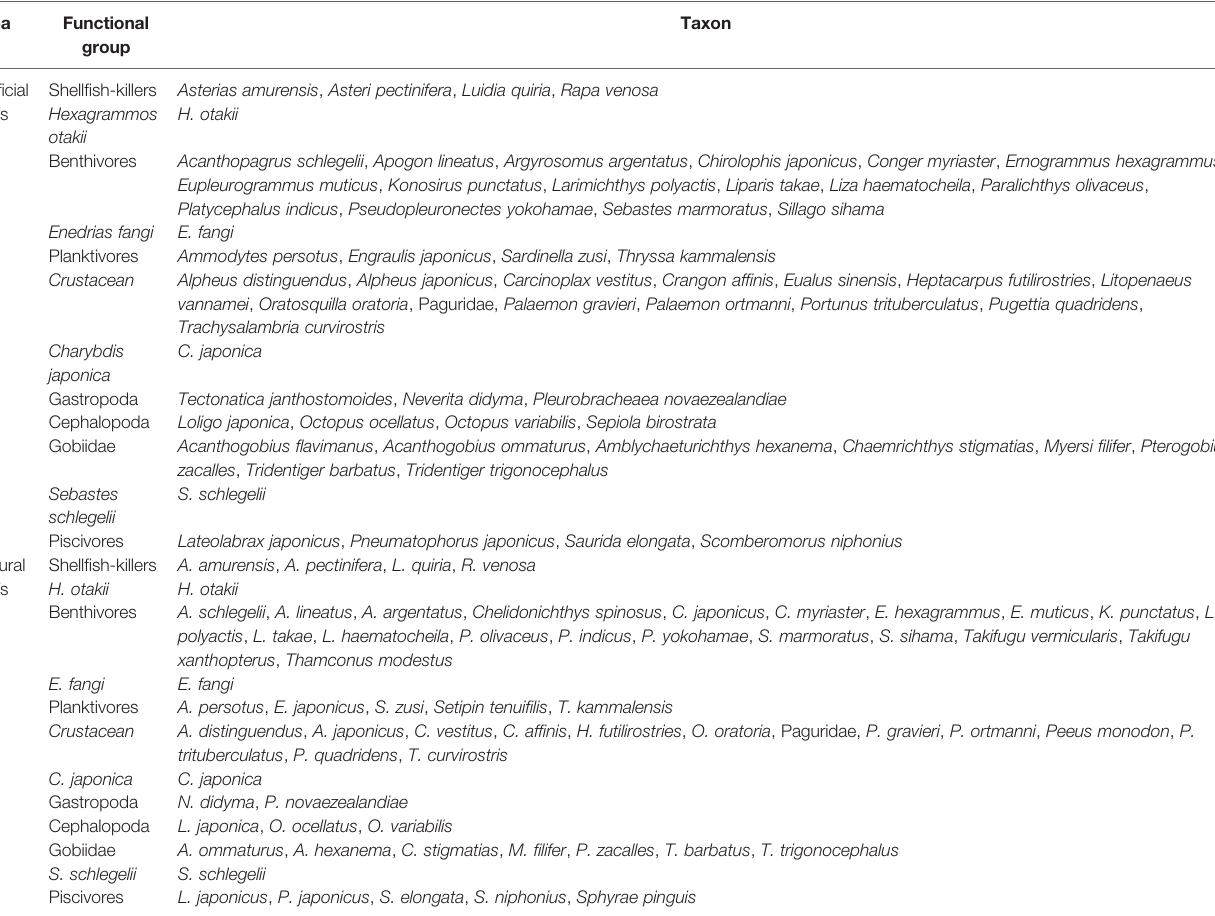
TABLE 1 | Species composition of functional groups in the nearshore arti fi cial and the natural reefs of Yellow Sea, China.